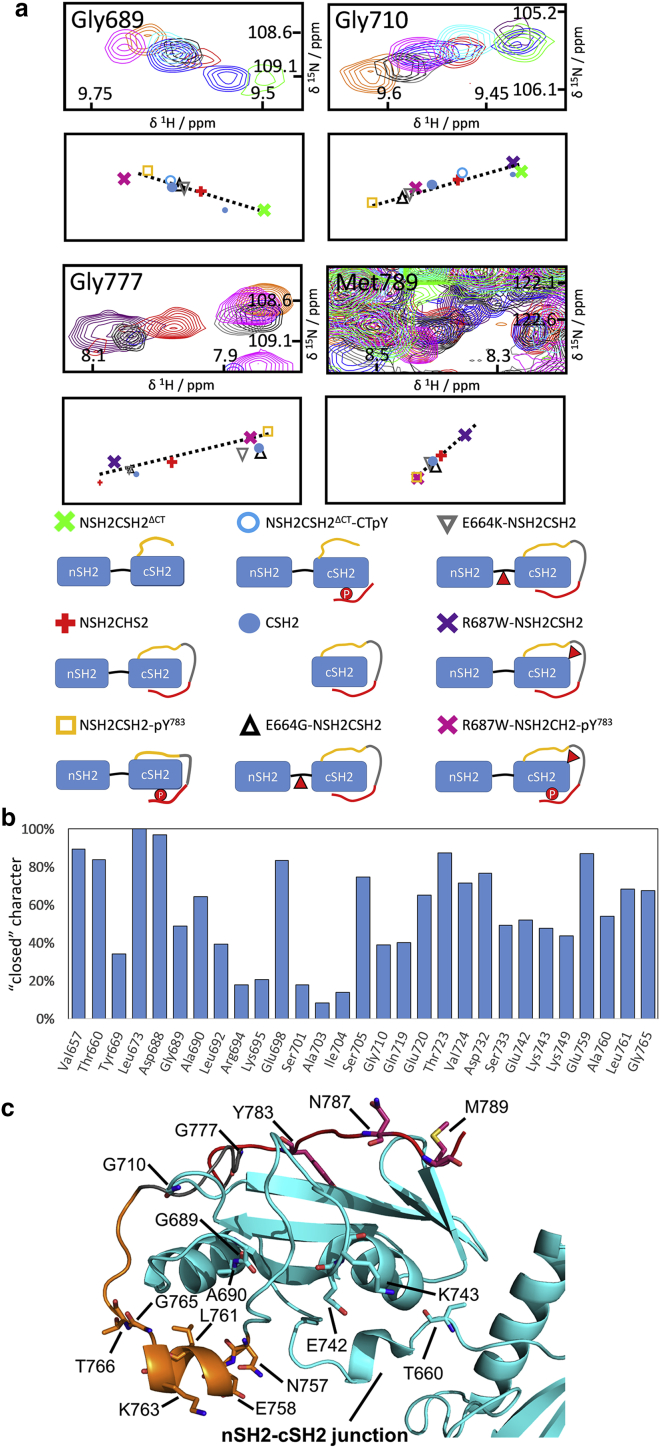
NMR spectra demonstrate that the C-terminus is partially bound in NSH2CSH2 constructs. (a) Superposition of the 1H,15N-HSQC NMR spectra of the tandem nSH2-cSH2 constructs is shown. Each pair of panels is focused on a particular residue and shows the raw NMR spectra (upper panel) with schematic illustrations of the crosspeak centroids (lower panel). The contour colors and centroid symbols are plotted according to the protein construct, as indicated in the key below, which uses cartoon representations wherein the NSH2-CSH2 junction, pre-C-terminus, C-terminal linker, and Tyr783 region are shown in black, yellow, gray, and red, respectively; phosphorylation of Tyr783 is indicated by a red circle with a white “P,” and sites of single residue substitutions are indicated by a red arrowhead. In each case, the crosspeaks are located on a vector connecting positions corresponding to fast-exchanging “open” (O) and “closed” (C) states (see main text). (b) Plot of the degree of “closed” character in the NSH2CSH2 construct is shown, estimated from the position of the corresponding crosspeaks on the O-C vector. (c) Model of the cSH2 protein (based on 4FBN) shows the location of residues whose crosspeak chemical shifts demonstrate O ⇌ C fast-exchange.